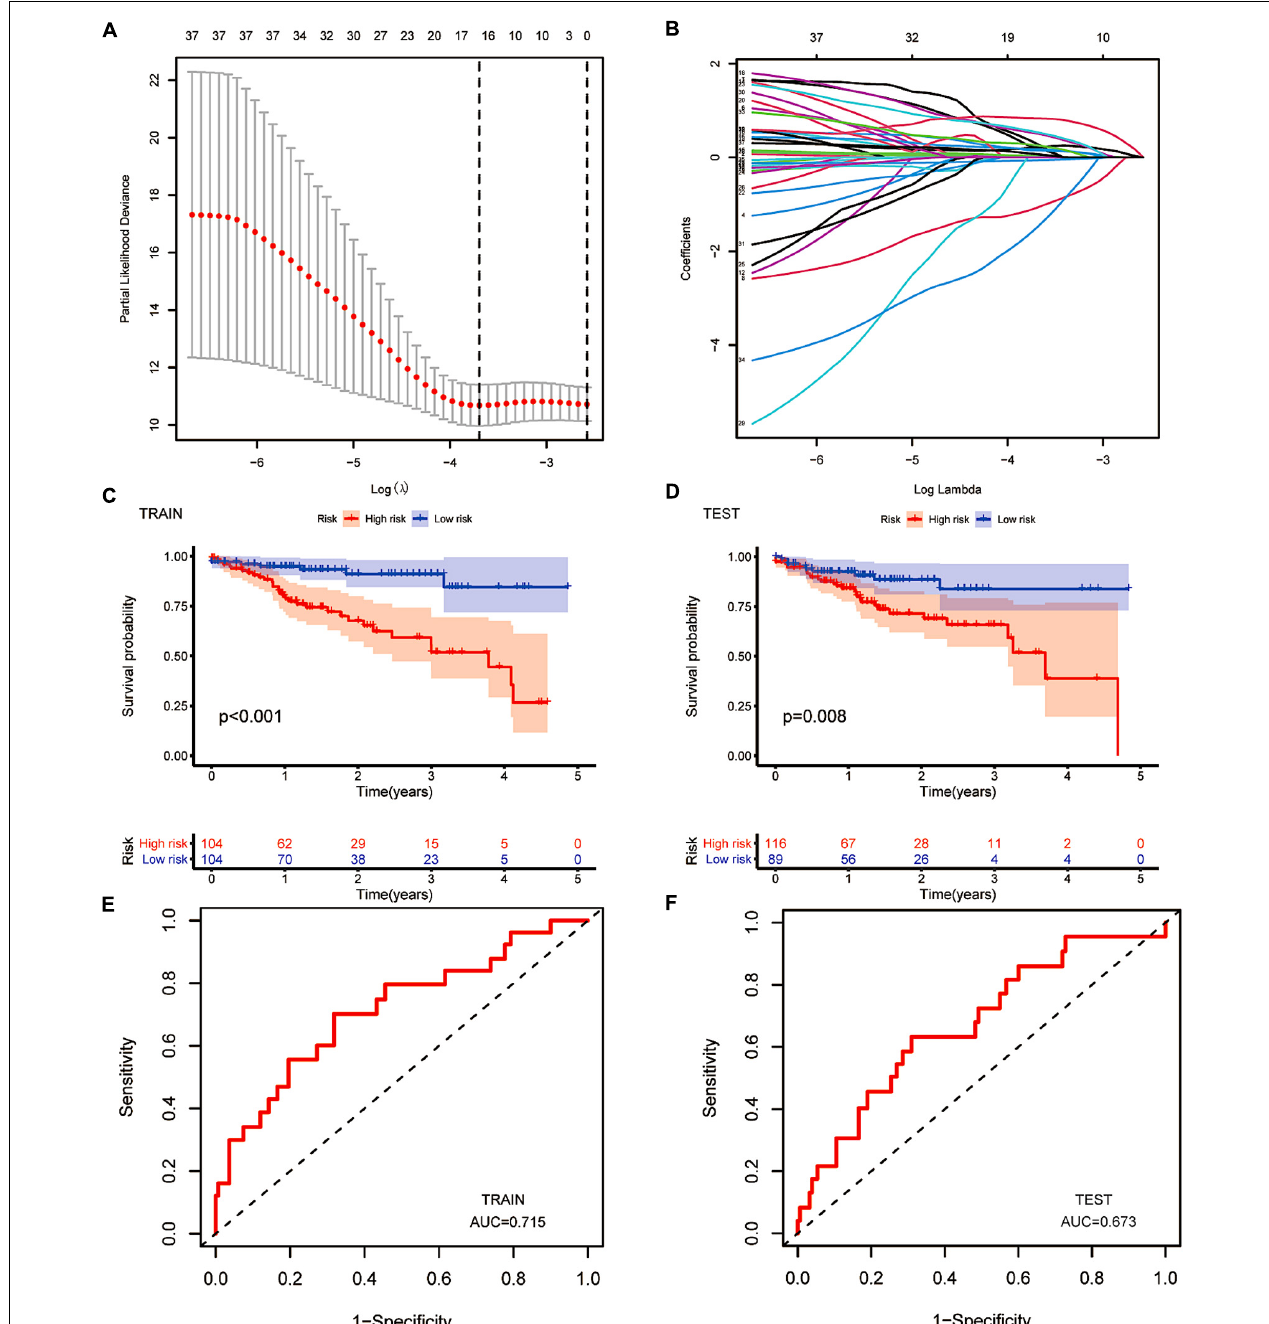
FIGURE 5 | The construction of a prognostic model. (A,B) Least absolute shrinkage and selection operator (LASSO) regression was performed, calculating the minimum criteria. (C,D) Kaplan–Meier curves showed the same result: the high-risk subgroup had worse overall survival than the low-risk subgroup in the testing group ( p < 0.001) and the training group ( p = 0.008). (E,F) ROC curves of 16 m6A-related prognostic lncRNAs for predicting overall survival in the training group (AUC = 0.715) and the testing group (AUC = 0.573).